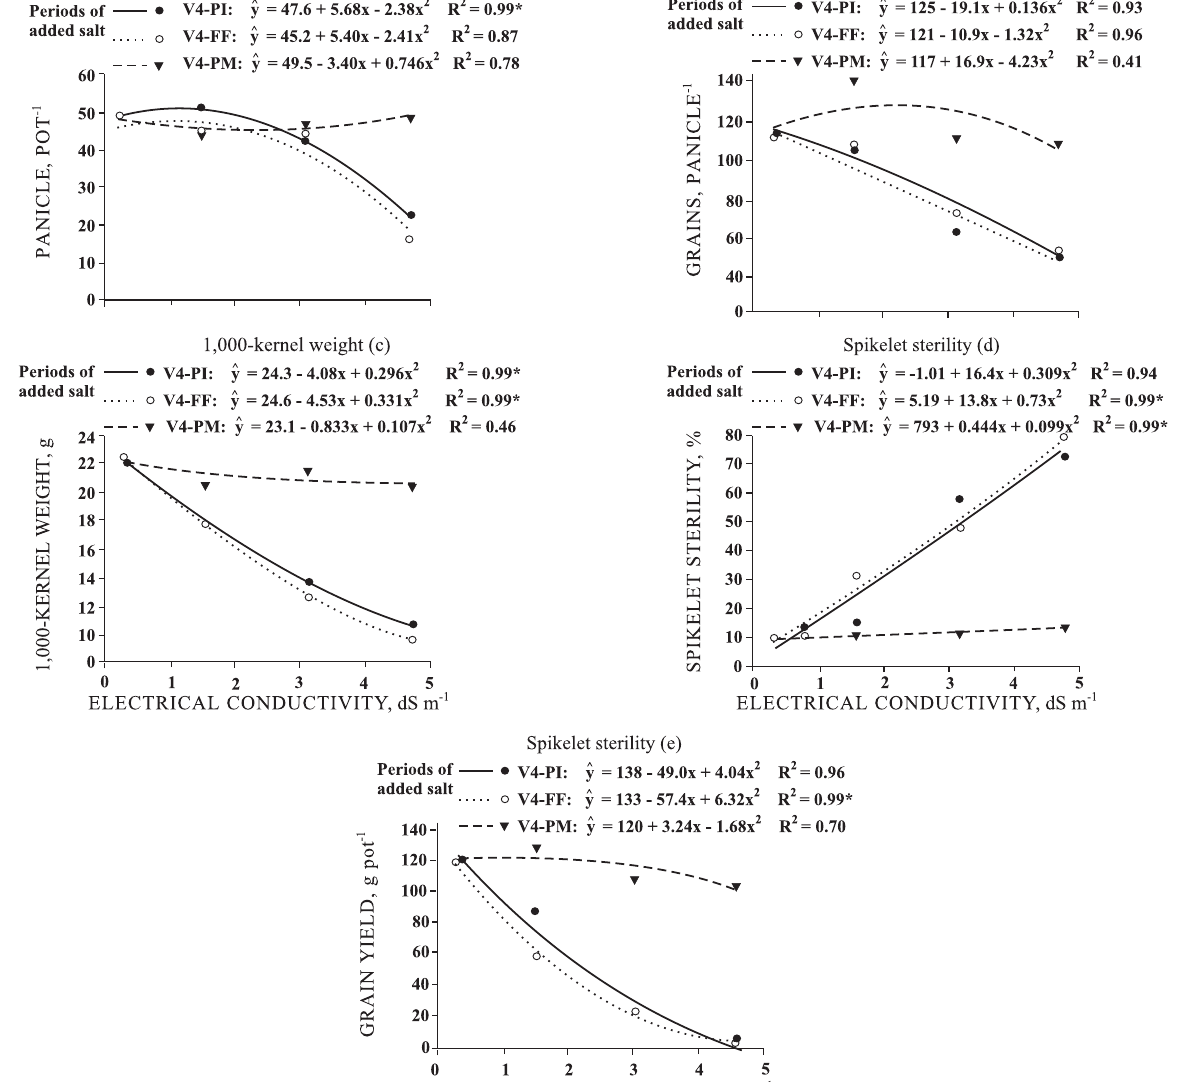
Figura 2. Number of panicles per pot (a), number of grains per panicle (b), 1-000 kernel weight (c), spikelet sterility (d) and grain yield (e) of flooded rice as affected by levels of salinity in different periods of its cycle, from panicle initiation. *: Significant (p <